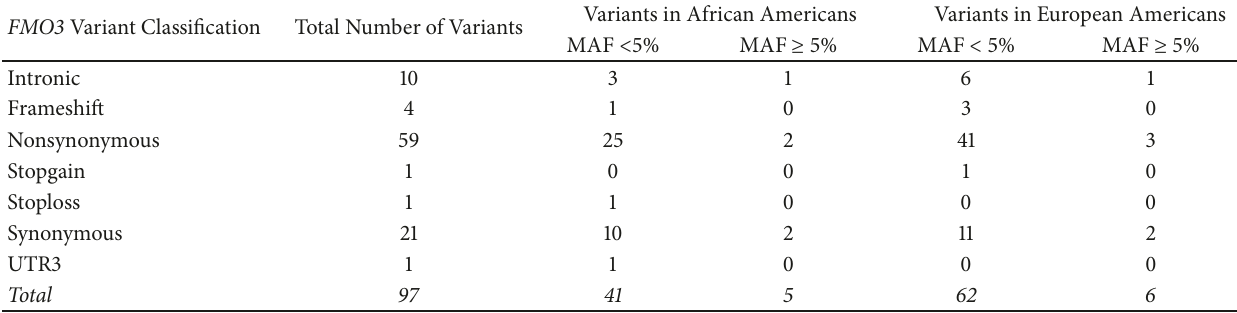
Table 2: Variants found in the FMO3 exome sequence, stratified by race and minor allele frequency. FMO3 Variant